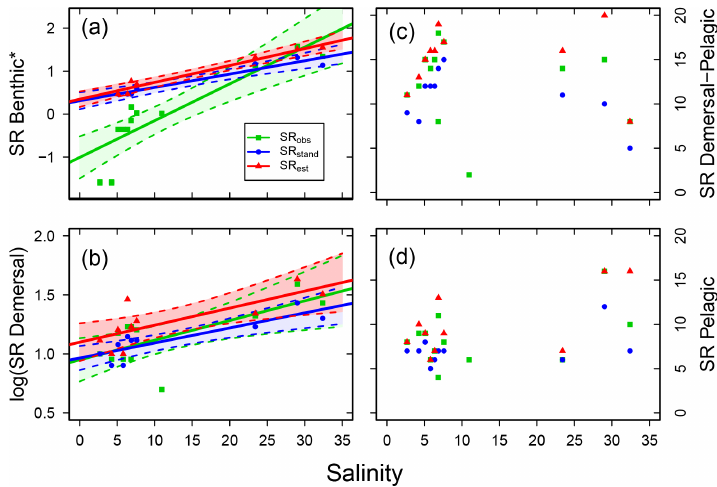
Figure 5. Fish species richness (SR) in relation to salinity in Swedish shallow coastal areas for different types of main vertical distribution, with (a) benthic ( ∗ Yeo–Johnson transformed for SR obs and log 10 transformed for SR std and SR est ), (b) demersal (log 10 transformed), (c) demersal–pelagic and (d) pelagic fish species. Each plot shows the observed, standardized and estimated SR and, for cases with a significant linear relationship ( P< 0 . 05), also the regression line (solid) and 95% confidence intervals (shaded areas surrounded by dashed lines). Please note that data points (Table S7), lines and shaded confidence intervals are overlying each other within the panels in some cases. For regression equations and statistics see Table